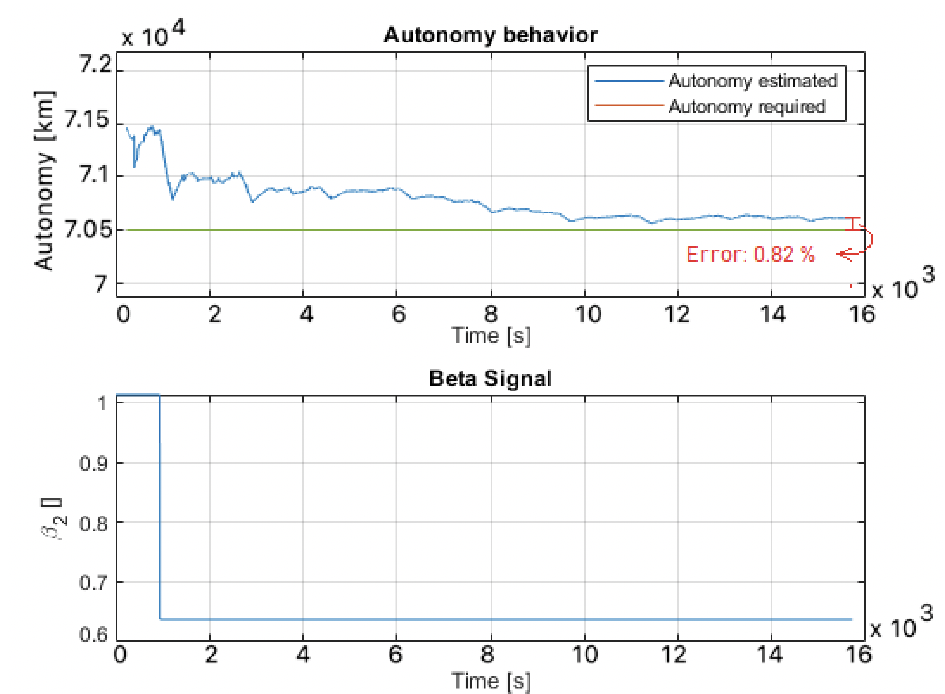
Figure 26. Case A, Good